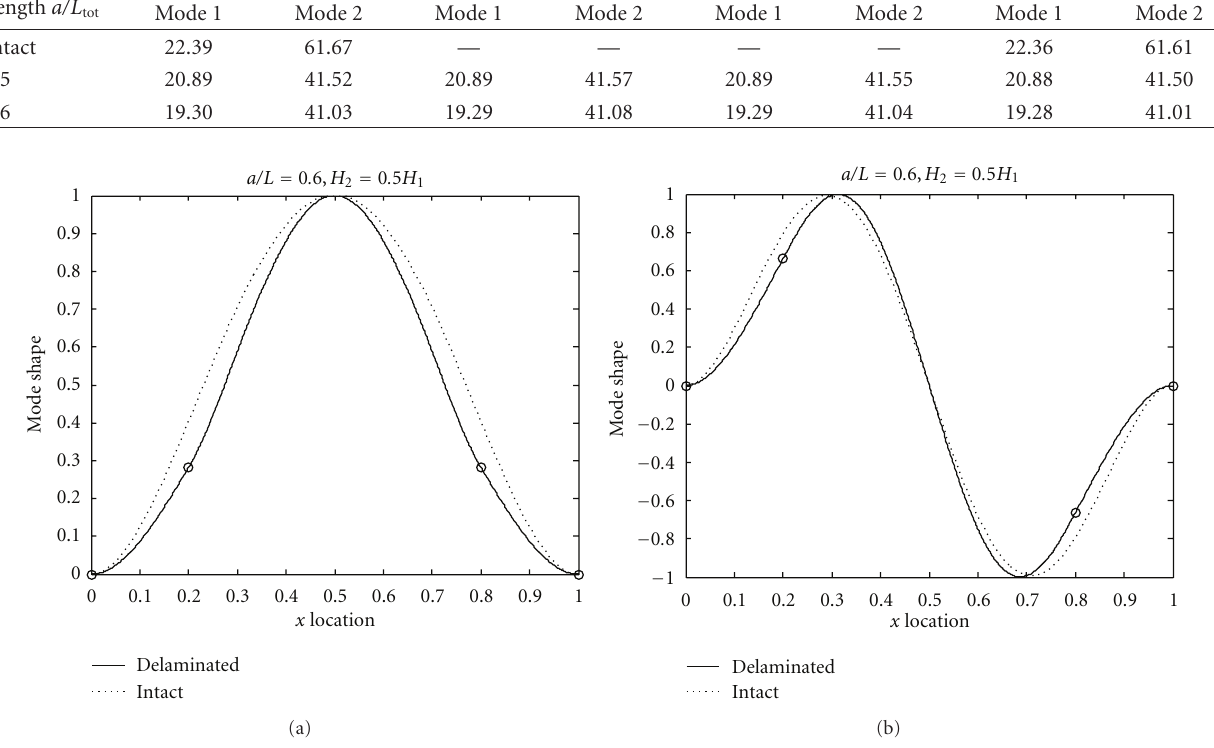
Figure 3: The first two natural modes for a 2-layered beam with centrally located midplane delamination, compared with those of the intact configuration. (Element totals are based on 1 element each for the outer intact segments, and equal element divisions for the top and bottom delaminated beam segments. Delamination tips and beam endpoints are visualized.), (a): 1st mode shapes, (b): 2nd mode